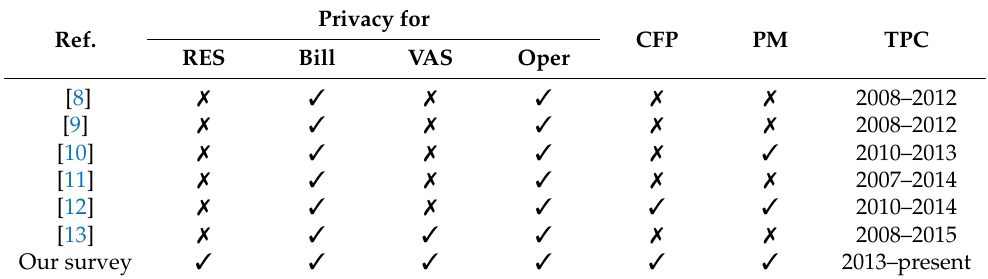
Table 1. Comparison of survey papers published in smart meter privacy preservation.